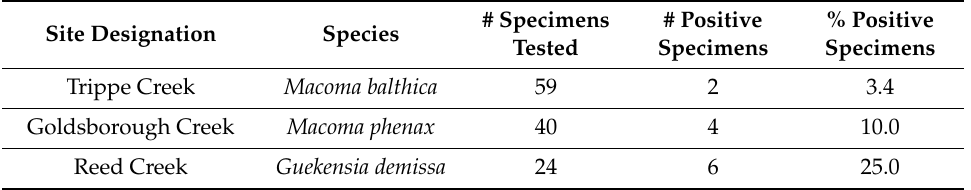
Bivalve specimens testing positive for the influenza A virus matrix gene by RT qPCR